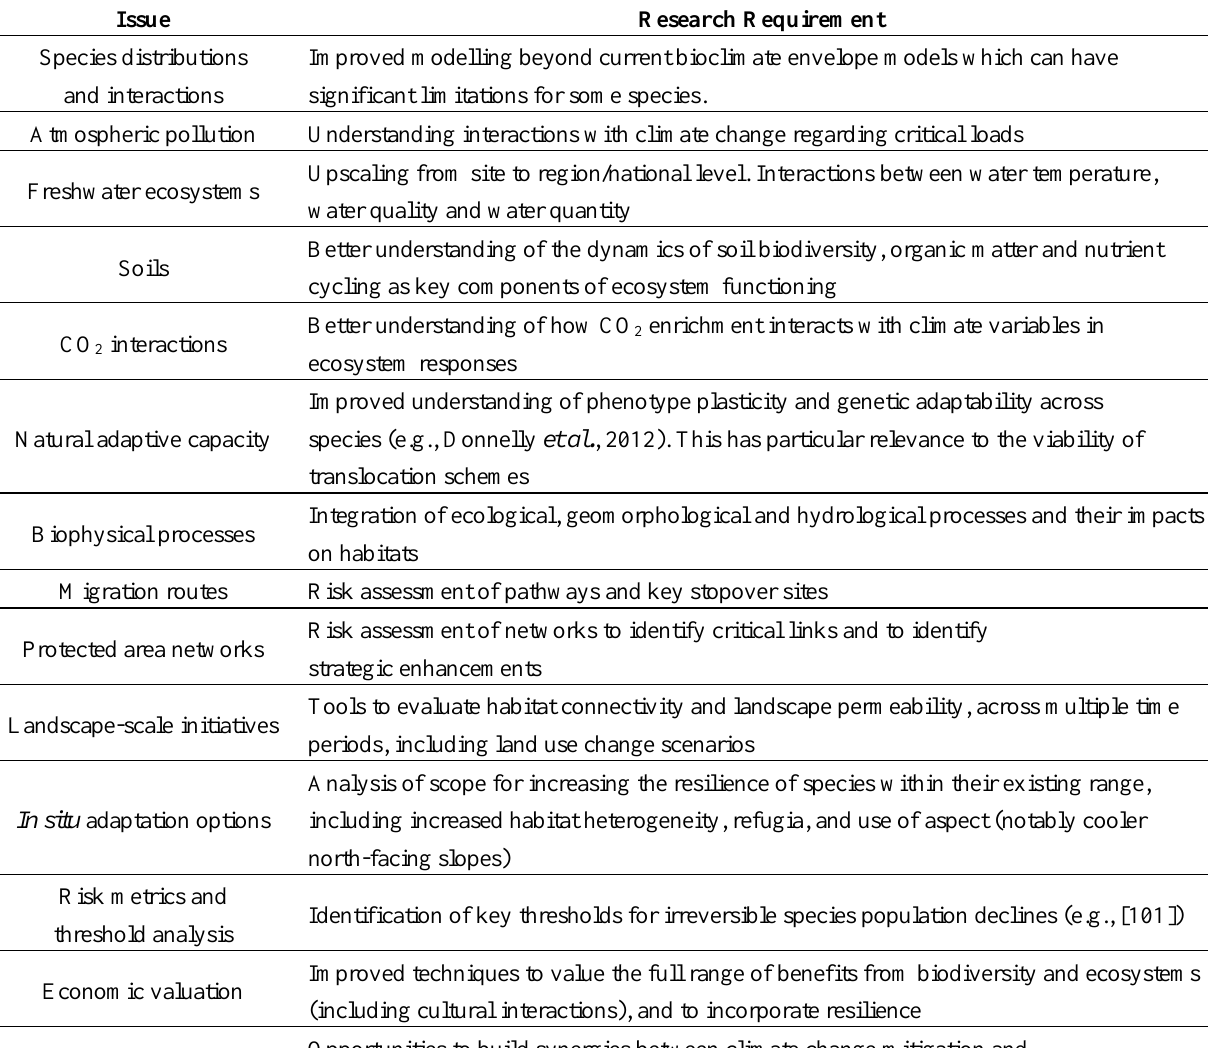
Table 6. Key research issues identified for biodiversity and ecosystem